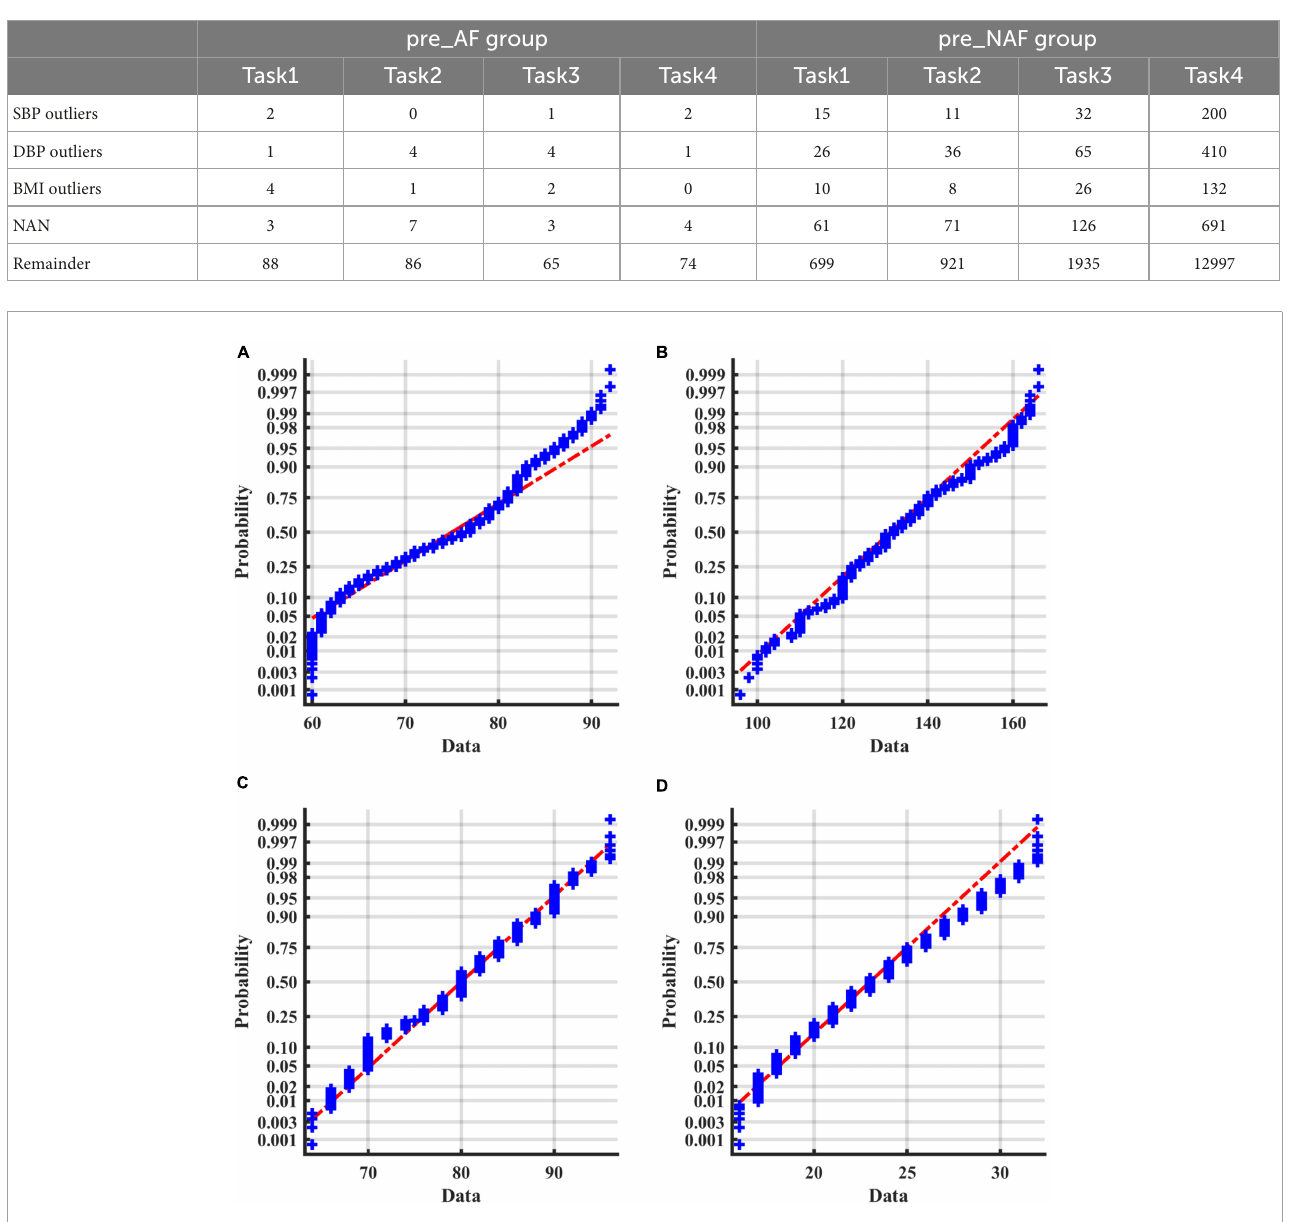
FIGURE2 Normal probability diagrams of 4 factors in the pre_NAF group in task1. The probabilities for different values of the factors are shown in blue. If all the sample points are close to the red line, it is reasonable to assume that the samples follow a normal distribution. (A) Age; (B) SBP; (C) DBP; (D)